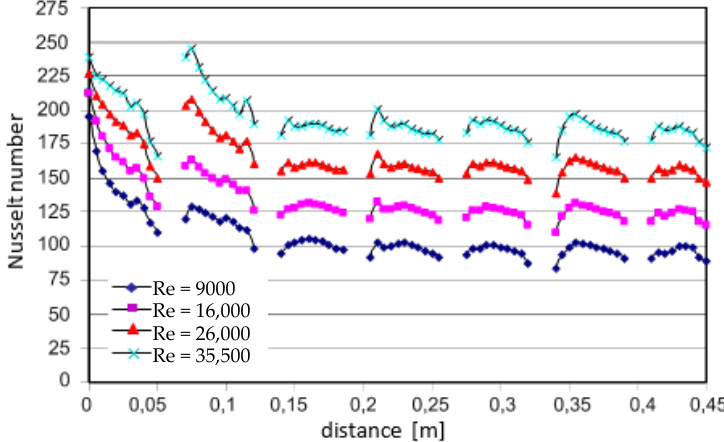
Figure 20. Local Nusselt number distribution for different Re numbers for a channel with slanted ribs on the bottom and the top surface of the channel (configuration_4).